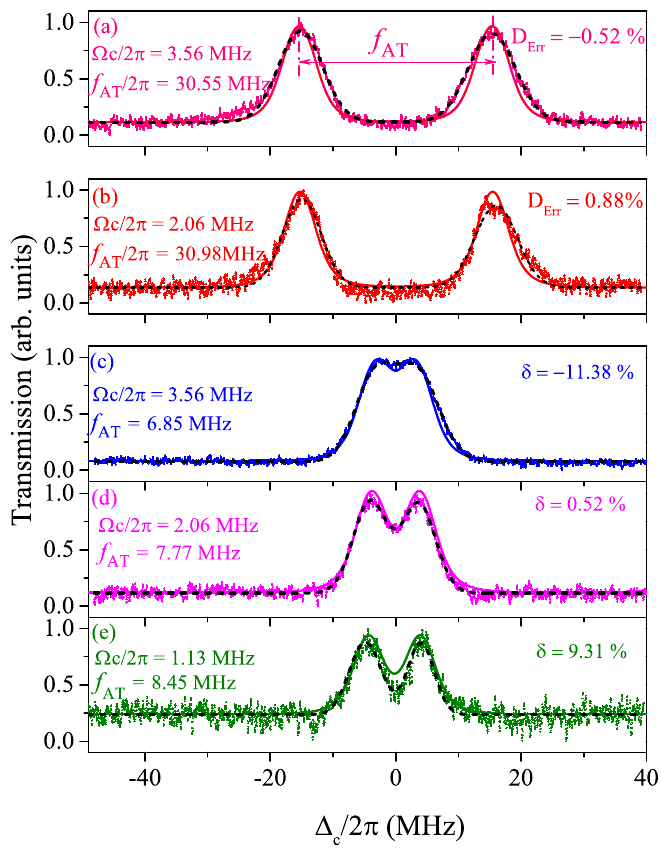
Figure 5. (color online) Measurements (symbols) and calculations (solid lines) of Rydberg EIT-AT spectra as a function of the coupling laser detuning ∆ c and indicated coupling Rabi frequencies for fixed probe Ω p = 2 π × 4.00 MHz and two microwave field Ω MW = 2 π × 30.71 MHz ( a , b ) and 2 π × 7.73 MHz ( c – e ). The black dashed lines display multipeak Lorentz fittings to the EIT-AT spectra for extracting f AT . The deviation D Err is defined as the ratio ( f AT − Ω MW )/ Ω MW . In ( a , b ), f AT locates in the linear region where the measured microwave electric field is independent on the coupling laser, corresponding D Err is smaller than 1%. In ( c – e ), f AT is in the nonlinear region where measured microwave electric field strongly dependent on the coupling laser Ω c